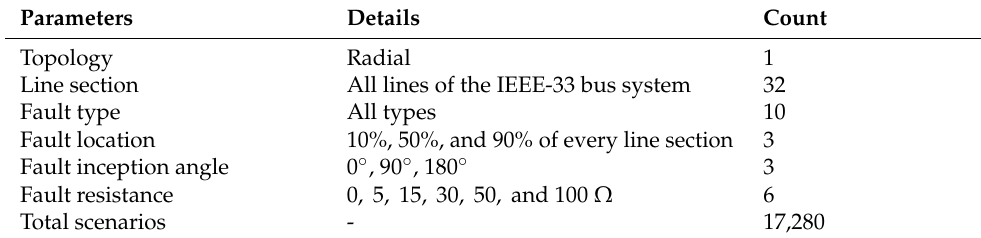
Figure 6. Single-line diagram of the IEEE-33 bus system. Table 1. Proposed method effectiveness under Different fault